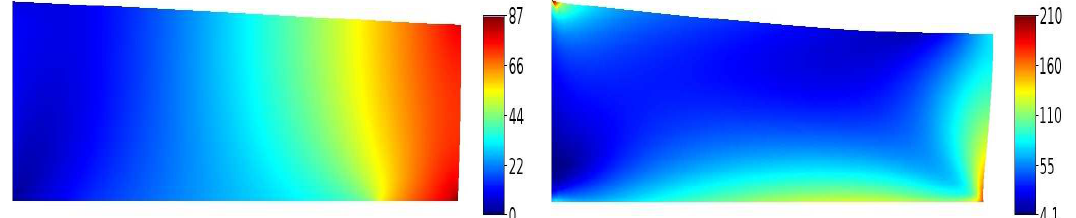
Figure 4. The Von Mises stress norm in the case of an insulated foundation (left) and in the case of a conductive foundation (right).